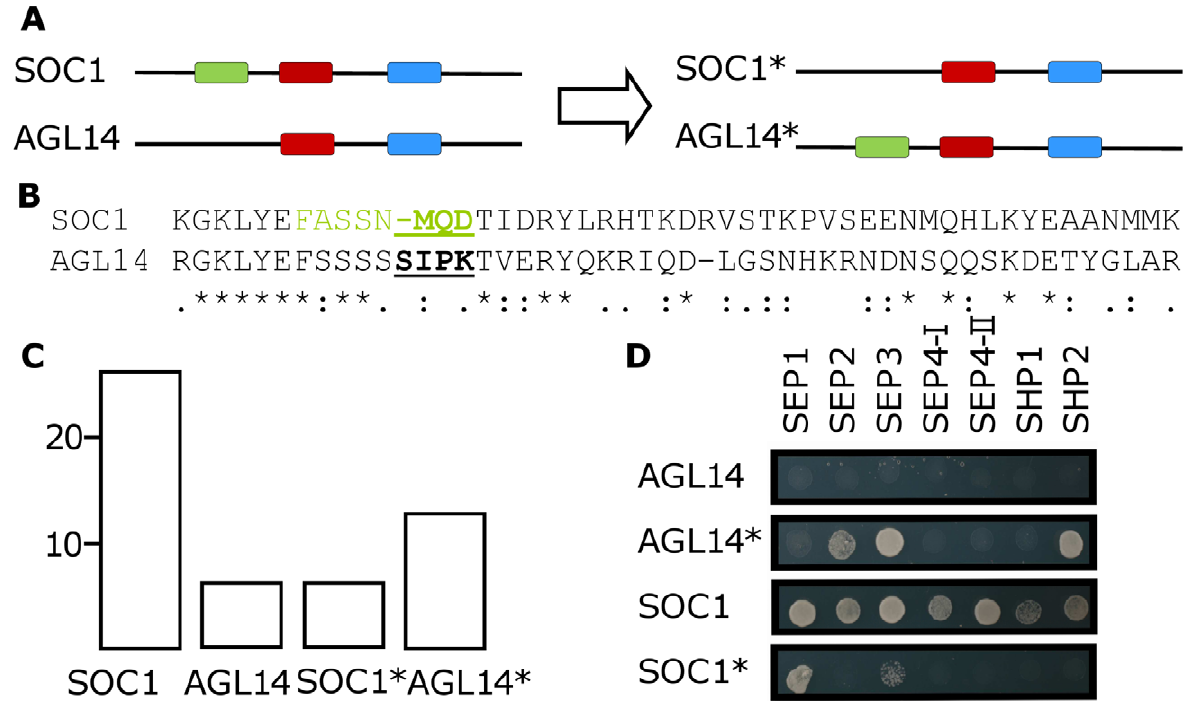
Figure 2. Example of the experimental validation approach. ( A ) Schematic representation of the SUPPRESSOR OF OVEREXPRESSION OF CO 1 (SOC1) and AGAMOUS LIKE14 (AGL14) MADS domain proteins. Due to the generated mutations one particular interaction motif (green rectangle) is swapped between these two Arabidopsis MADS domain transcription factors. The swapped motif is located in the ‘‘hotspot’’ region between the MADS and I-domain. ( B ) Part of a sequence alignment of AGL14 and SOC1, including the motif that was selected for mutagenesis (indicated in green in the SOC1 sequence). The mutated residues that were swapped between the two proteins are shown bold/underlined. ( C ) Bar diagrams showing the number of interaction partners for SOC1, AGL14 and their mutated counterparts SOC1* and AGL14*, respectively; see Table 1. For these two proteins, the F-scores of predicted mutant interactions are 0.63 and 0.71, respectively. ( D ) Example of a matrix-based yeast two-hybrid screen. Yeast was spotted on medium lacking Leucine, Tryptophan, and Histidine, and supplemented with 1 mM 3-amino 1,2,4-triazole to suppress transcriptional autoactivation. Growth and hence interaction events, was scored after incubation at 20 u C for 4 days.